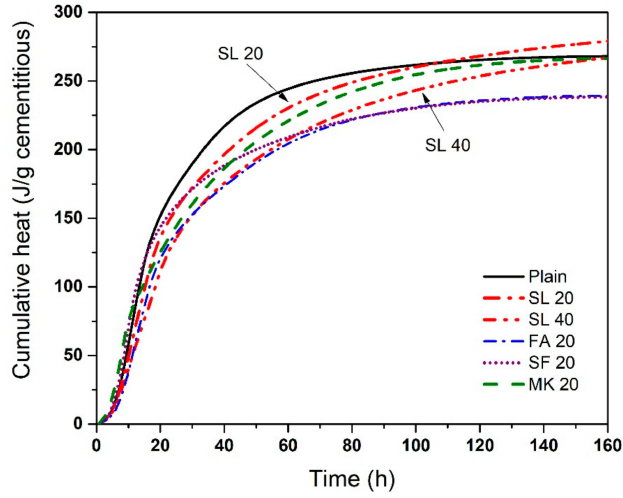
Figure 7. Cumulative heat release of cement paste with various SCMs at 23 ◦ C. The difference in the cumulative heat of repeat specimens was generally <